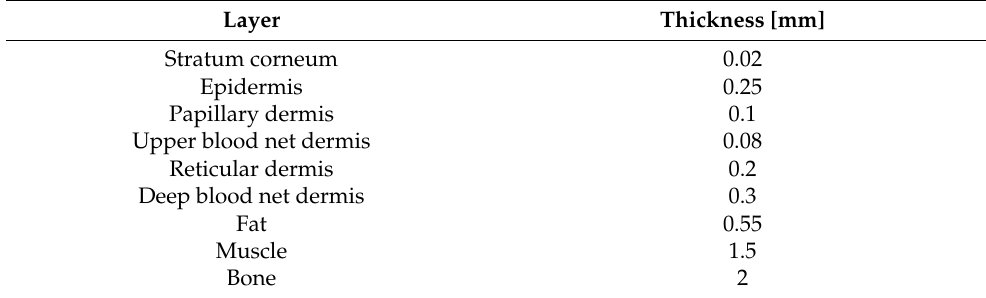
Table 2. Thicknesses of the layers of the proposed finger model